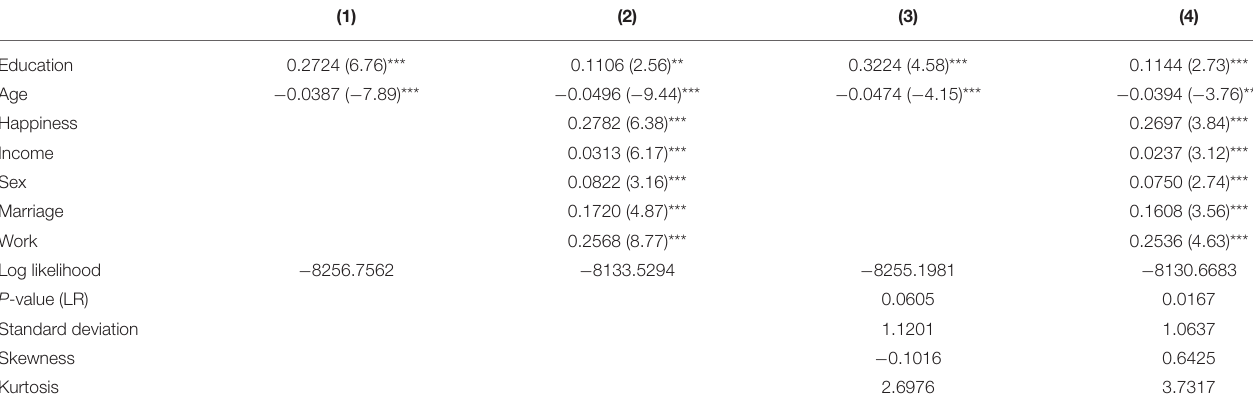
TABLE 2 | A test of high education’s influence on residents’